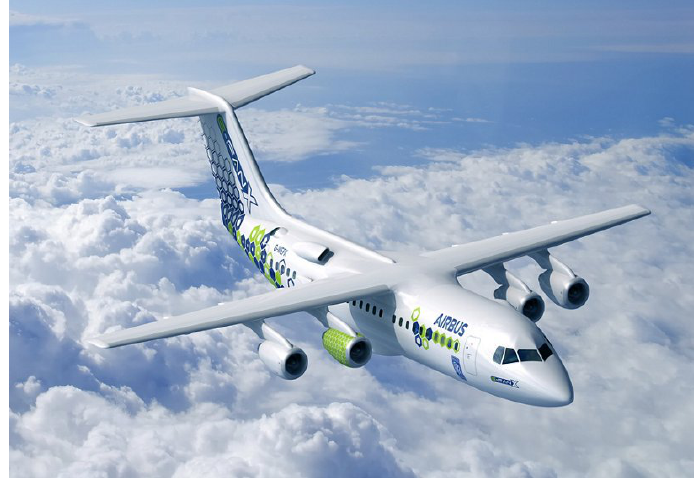
Figure 5. E-FAN X concept aircraft. The green engine was substituted by an electric